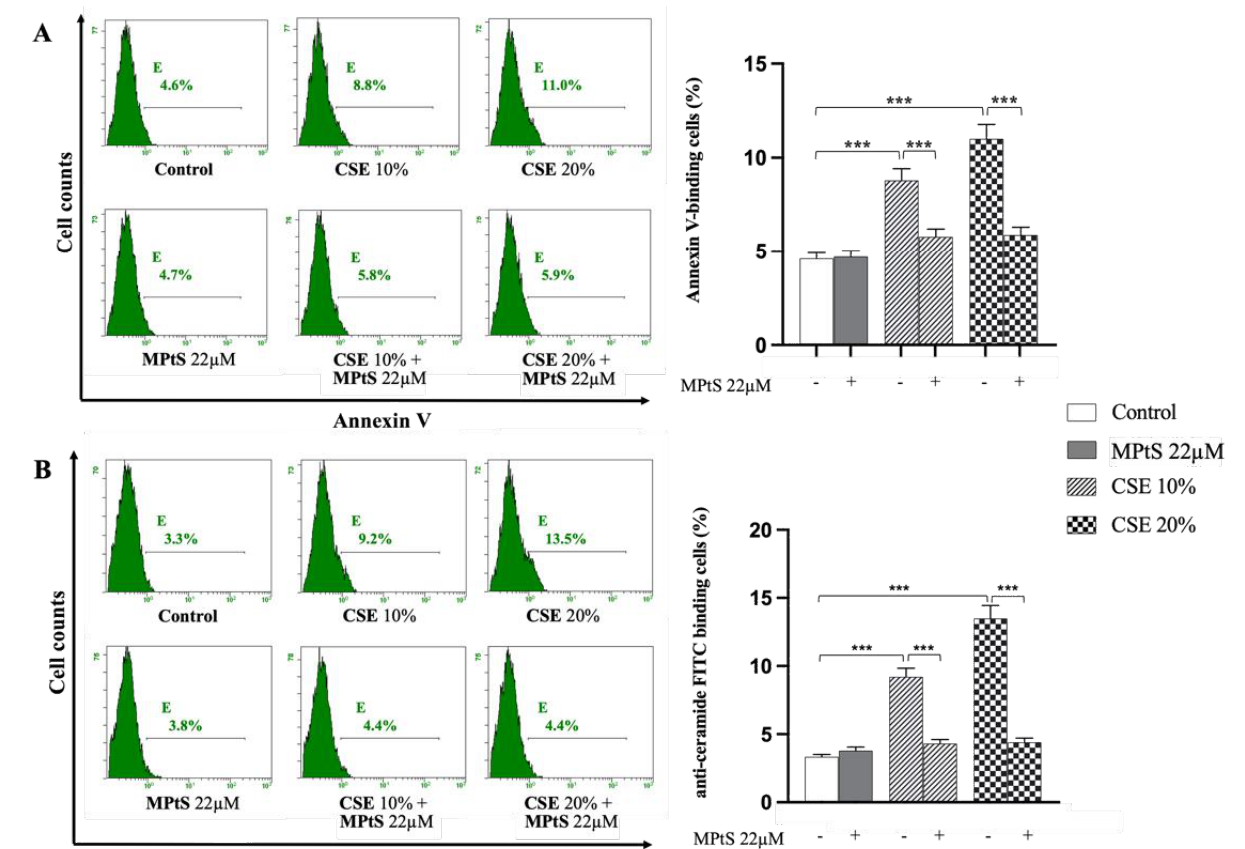
Figure 3. Mixture of plant sterols (MPtS) inhibits cigarette smoke extract (CSE)-induced eryptosis with decrease of PS exposure and ceramide production. ( A ) Percentage of PS-exposing erythrocytes and ( B ) ceramide formation in 10% or 20% CSE-treated RBCs incubated for 4 h in the absence or in co-treatment with 22 μM MPtS measured by flow cytometry. RBCs incubated with Ringer solution were used as control. Protocol of measurement at Section 4.4. Values are means ± SD of ( n = 6) experiments carried out in triplicate. *** p < 0.001 (ANOVA associated with Tukey ’ s test).